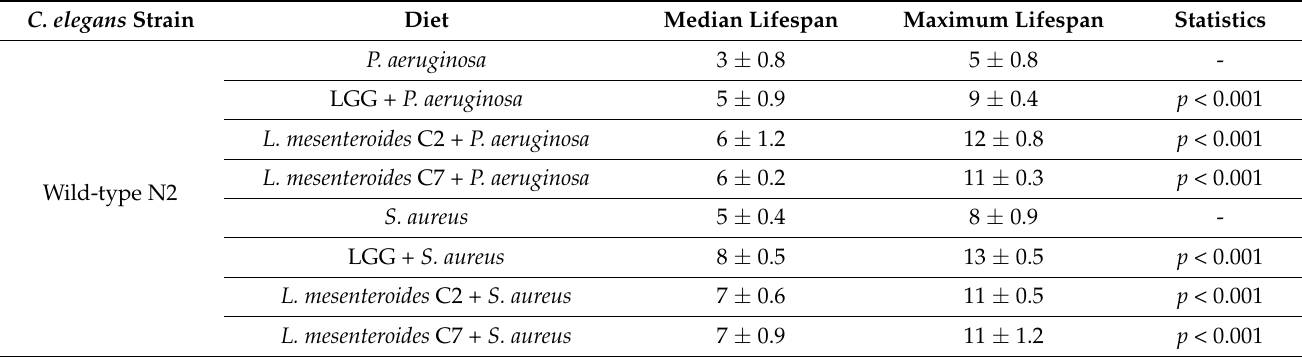
Table 4. In vivo resistance to pathogens. Survival assay of N2 worms fed co-cultures of LAB and P. aeruginosa or S. aureus . The lifespan of worms fed pathogens alone was reported as the control. Three experiments were performed in triplicate for each